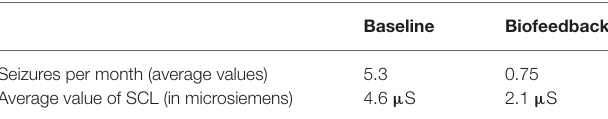
TABLE 2 | Number of seizures per month and the average values of SCL (in microsiemens)